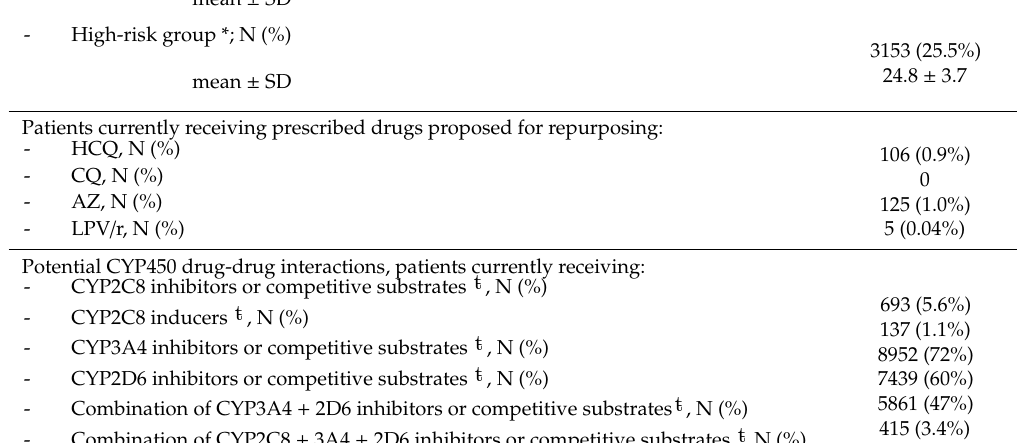
Table 4: Non-ASCII Letters (Excluding Accented Letters)